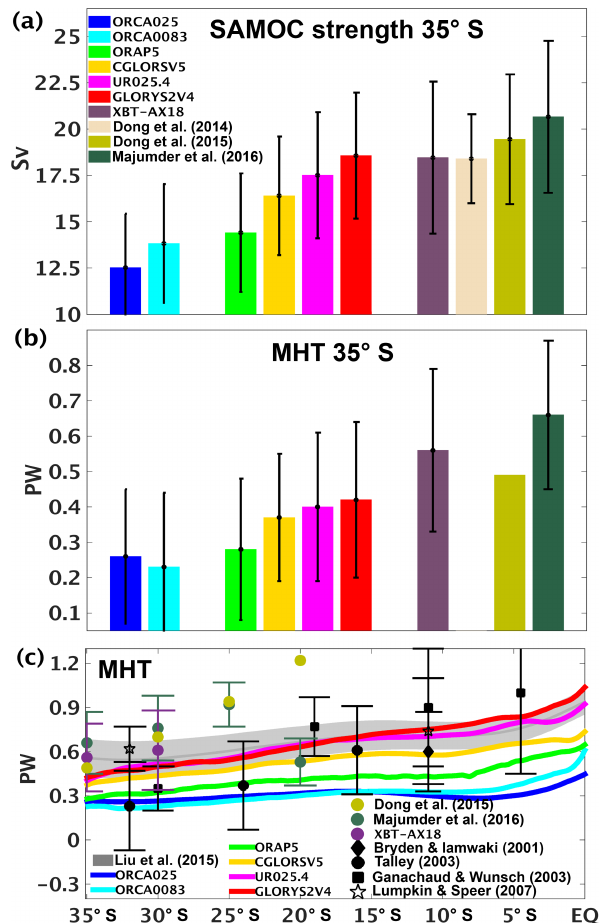
Figure 3. (a) SAMOC strength (Sv) at 35 ◦ S, (b) MHT (PW) at 35 ◦ S, and (c) MHT (PW) as a function of latitude averaged over 1997–2010. The black bars in (a) and (b) represent monthly stan- dard deviations except for the XBT-AX18, Dong et al. (2015), and Majumder et al. (2016) estimates, which correspond to quarterly, weekly, and daily standard deviations, respectively. In panel (c) , the Liu et al. (2015) MHTs and their annual standard deviation are rep- resented by the shaded grey area. The products are also compared to hydrographic and inverse modelling estimates from the literature at several